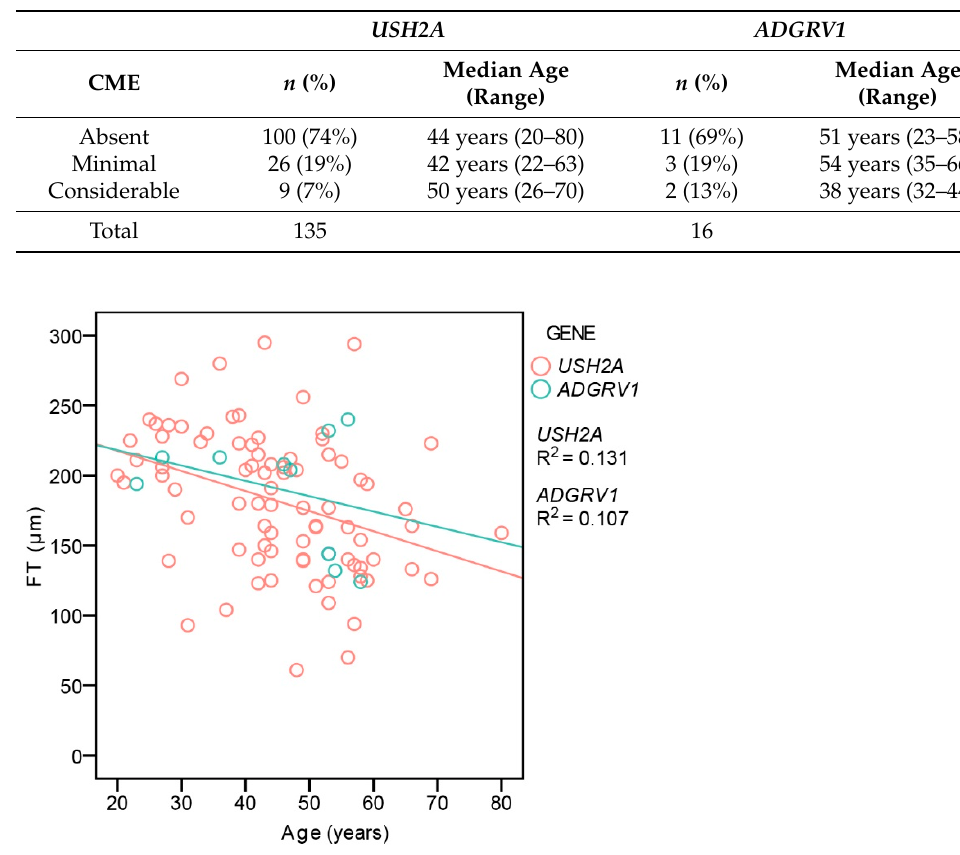
Table 3. Distribution of different degrees of CME in USH2A and ADGRV1 patient groups.